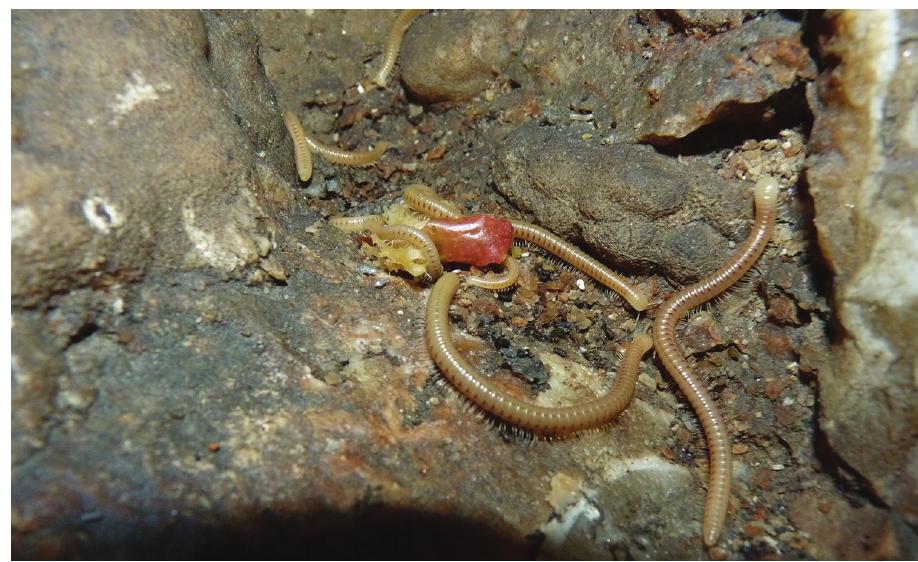
Figure 2. Living specimens of Skleroprotopus membranipedalis in Shi-Hua